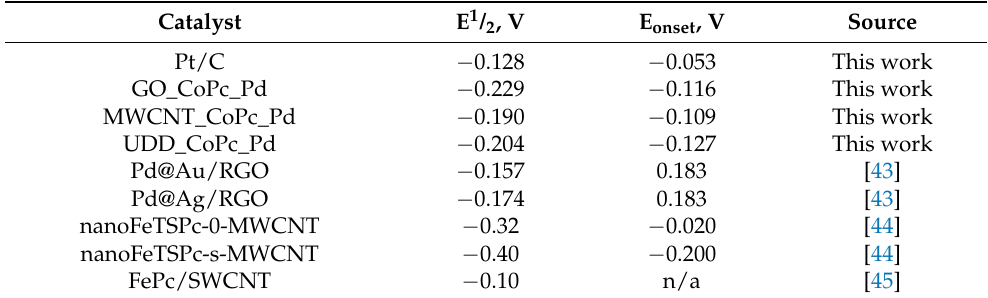
Table 5. Comparison of characteristics obtained in present work with literature